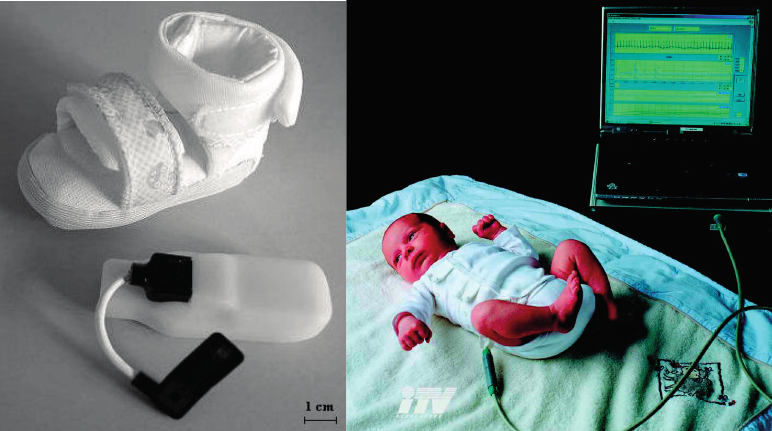
Figure 14. The BBA bootee ( left ) [9] Copyright © 2007 IEEE and the sensory baby vest ( right ) [12] Copyright © 2006